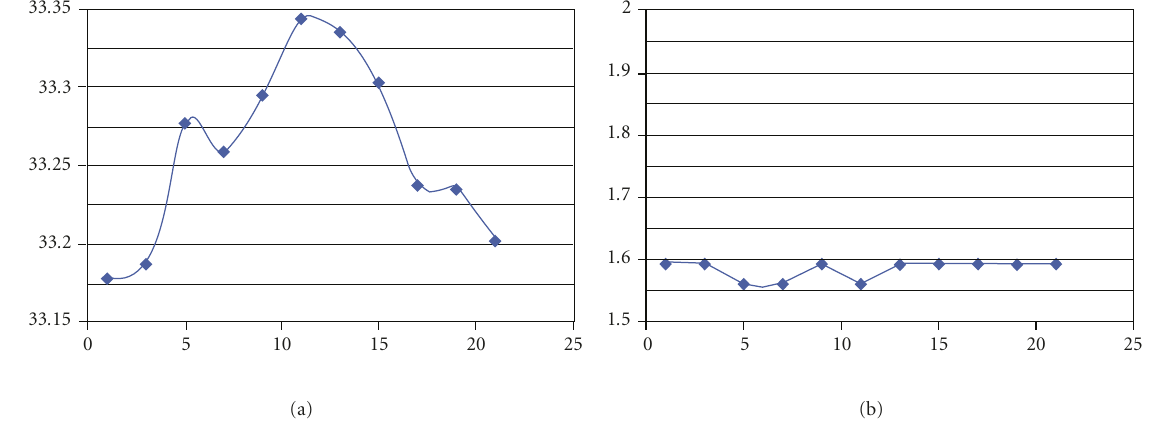
Figure 8: Performance of the proposed algorithm at di ff erent settings of threshold T edge : (a) PSNR and (b) Run Time.